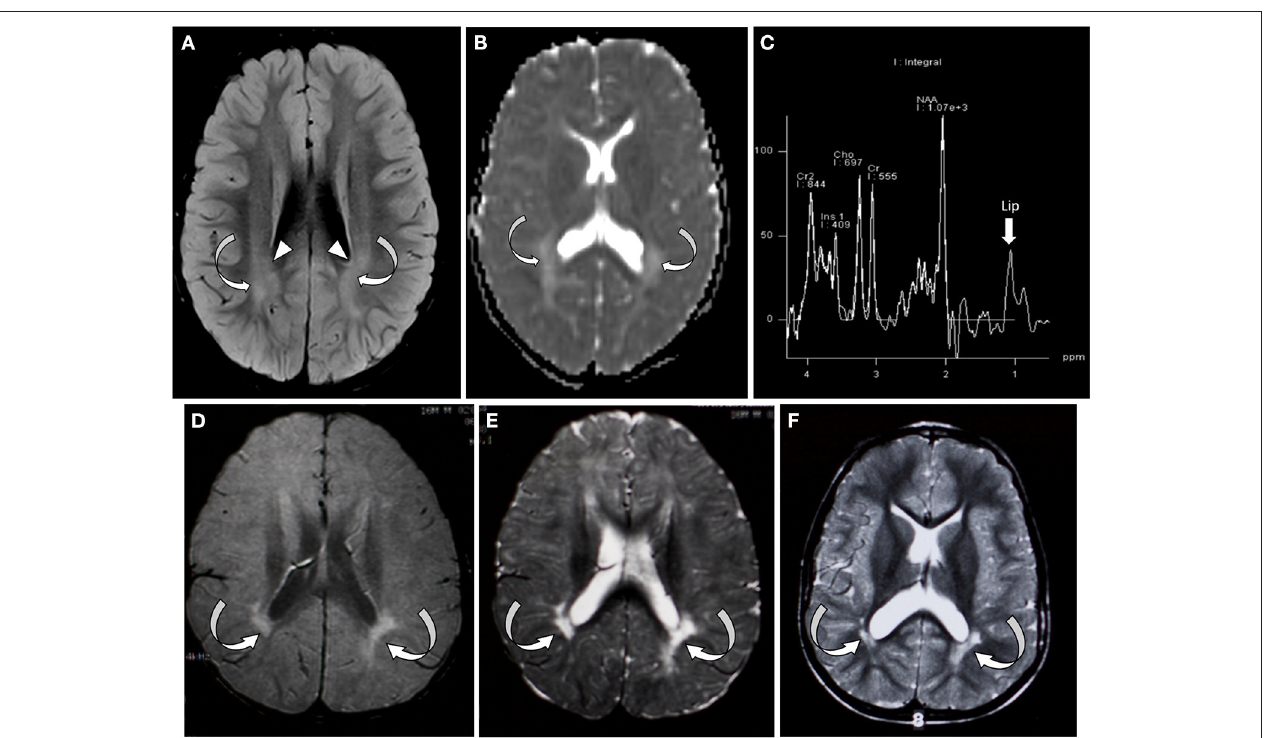
FIGURE 1 | Brain MRI/MRS from patient 1 (A–C) and patient 2 (D–F) . (A) Axial FLAIR sequence at the level of the lateral ventricle and centrum semiovale at 4 years of age showing bilateral symmetric areas of amorphous hyperintensity (curved arrows) within the periventricular white matter. Notice the hyperintensity is seen extending up to the ventricular margin (arrowhead). (B) Apparent diffusion coefficient map of the brain through the lateral ventricles showing areas of hyperintensity suggestive of facilitated diffusion (absent diffusion restriction/curved arrows). (C) Single-voxel MRI spectroscopy with the voxel placed over the white matter showed slightly elevated lipid peak (arrow). (D–F) Axial FLAIR and axial T2 images through the centrum semiovale and ventricles performed at 1, 2, and 4 years of age, respectively. Arrows indicate bilateral periventricular white matter thinning and hyperintensity, predominantly in the periatrial